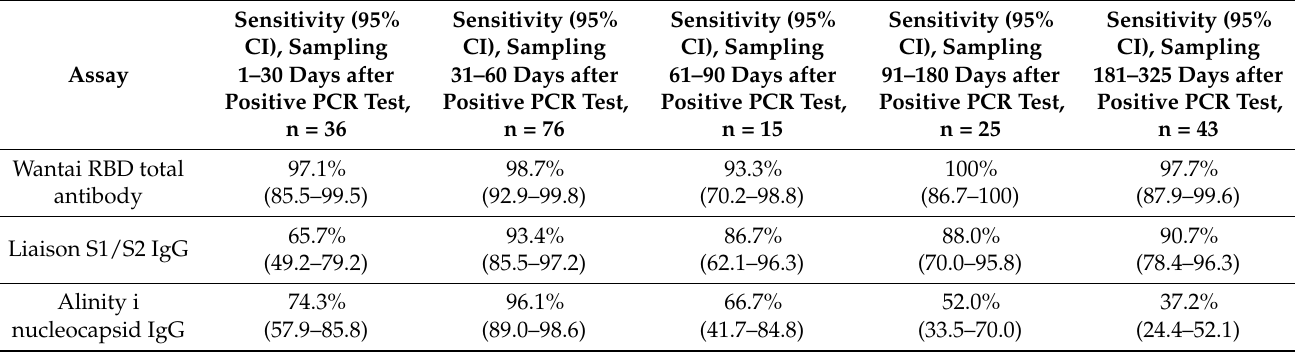
Table 4. Sensitivities for the commercial assays in relation to sampling time following PCR positivity using the two-step ELISA as reference.